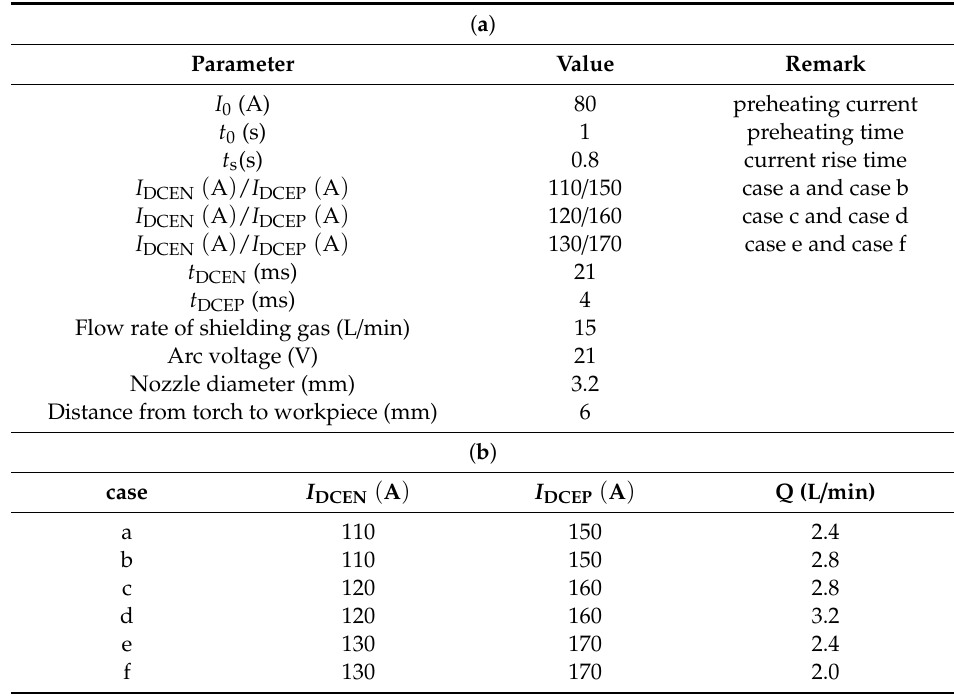
Table 2. ( a ) Variable polarity plasma arc welding (VPPAW) process parameters; ( b ) VPPAW process